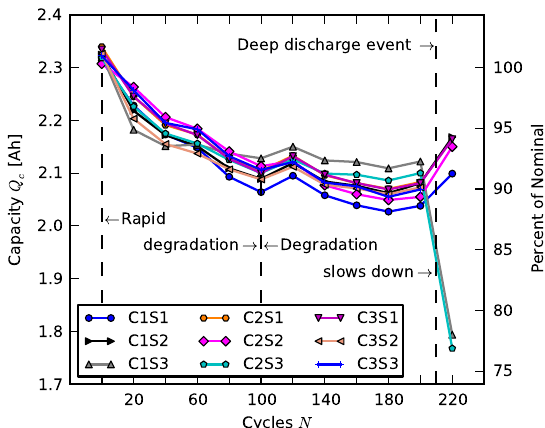
Figure 7. Individual capacities of the baseline pack comprised of new